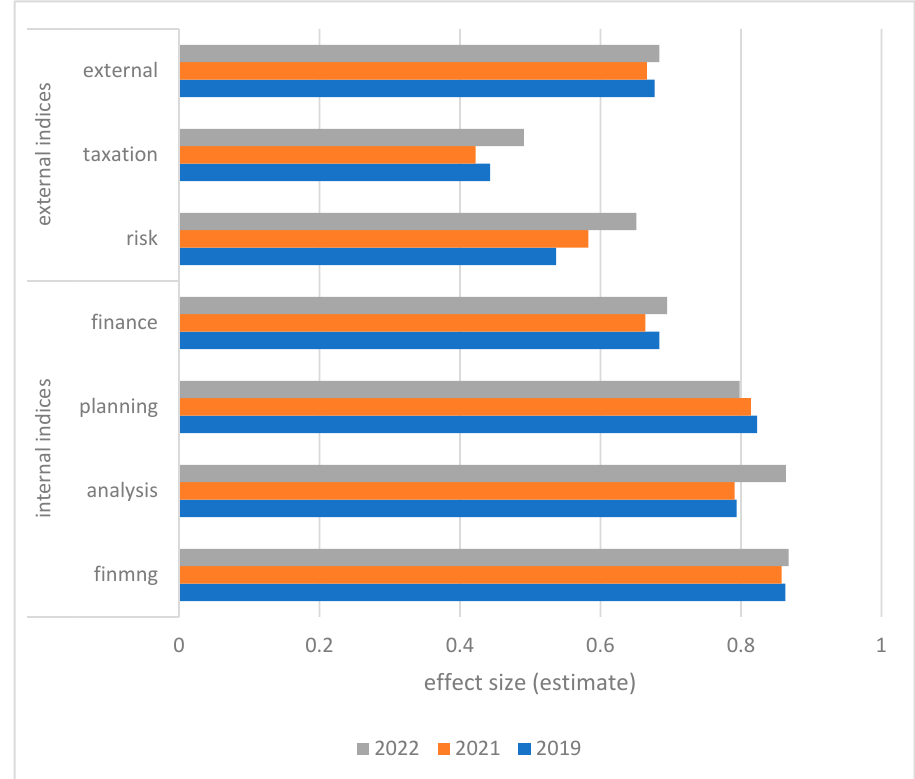
Figure 2. Standardized estimates of internal and external financial literacy of the 2019, 2021, and 2022 models.